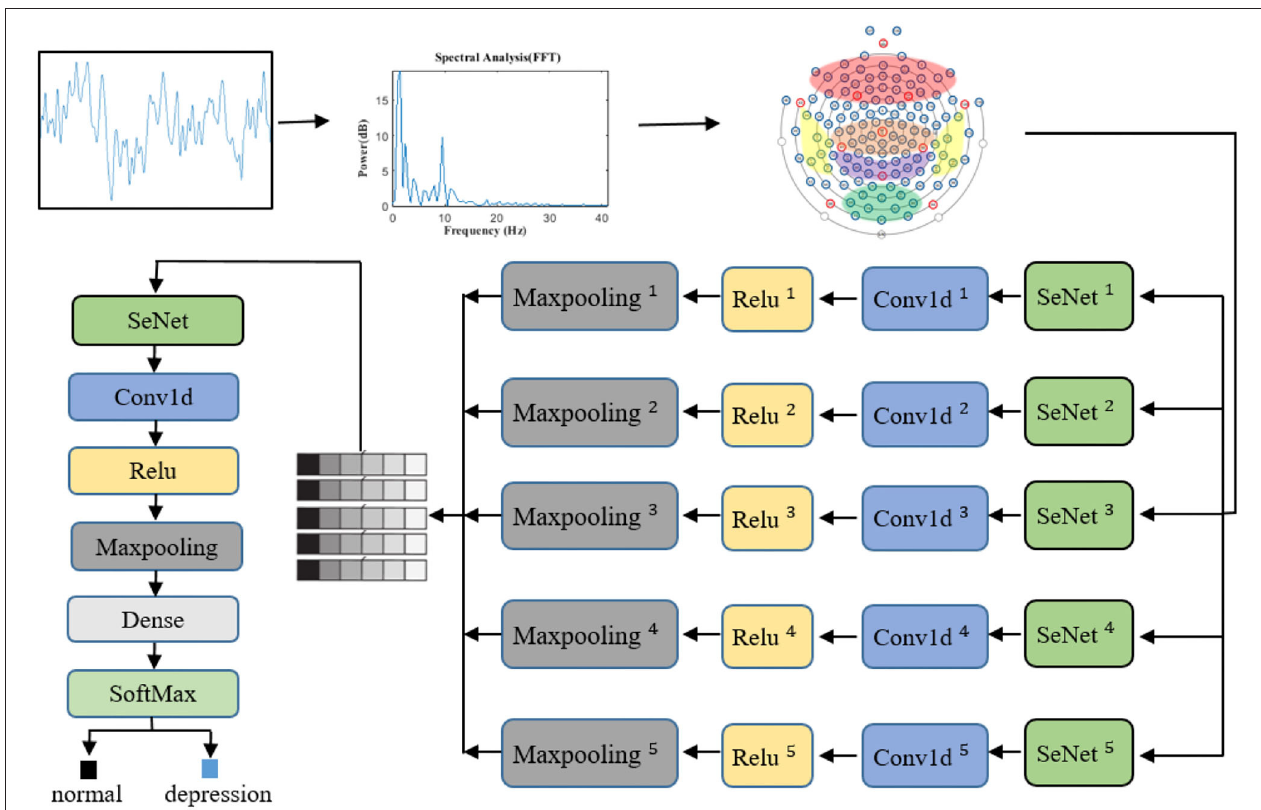
FIGURE 4 | The proposed architecture of the CNN model based on SENet and SparNet. Where ** represents the level of the convolution filter. Conv1d is a one-dimensional convolution operation.